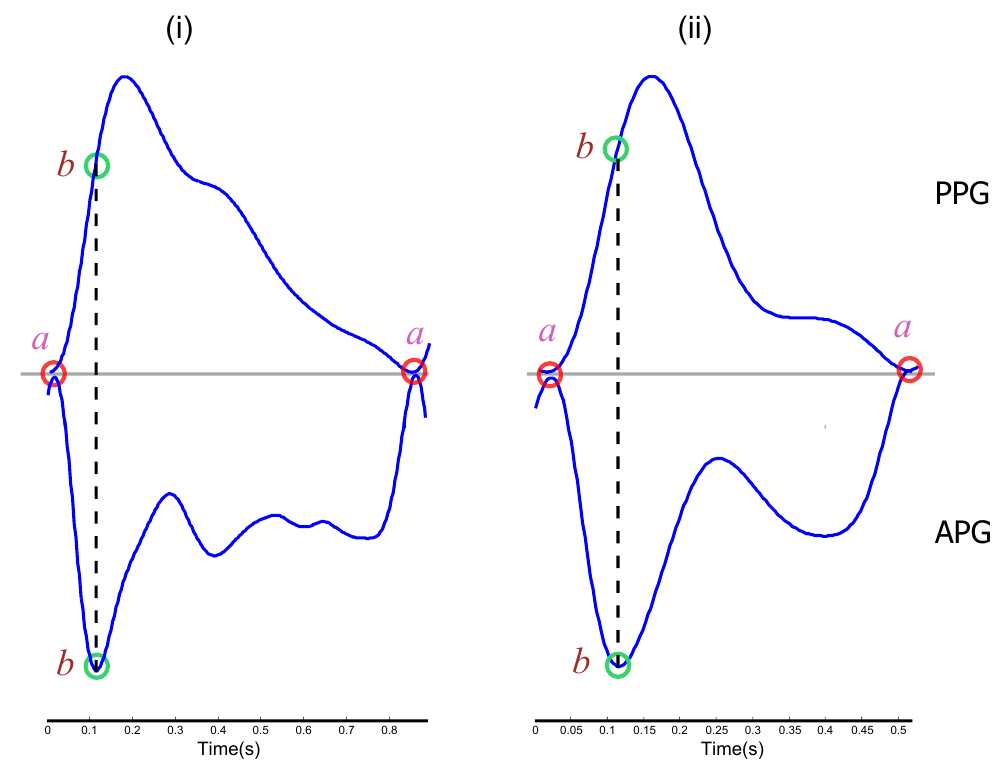
Figure 3. Projection of a and b waves on the aa area of the fingertip photoplethysmogram signal (PPG) and its second derivative (APG). ( i ) One heart beat of the PPG and its APG measured from a subject at rest; ( ii ) one heart beat of the PPG and its APG measured from a subject after simulated heat stress